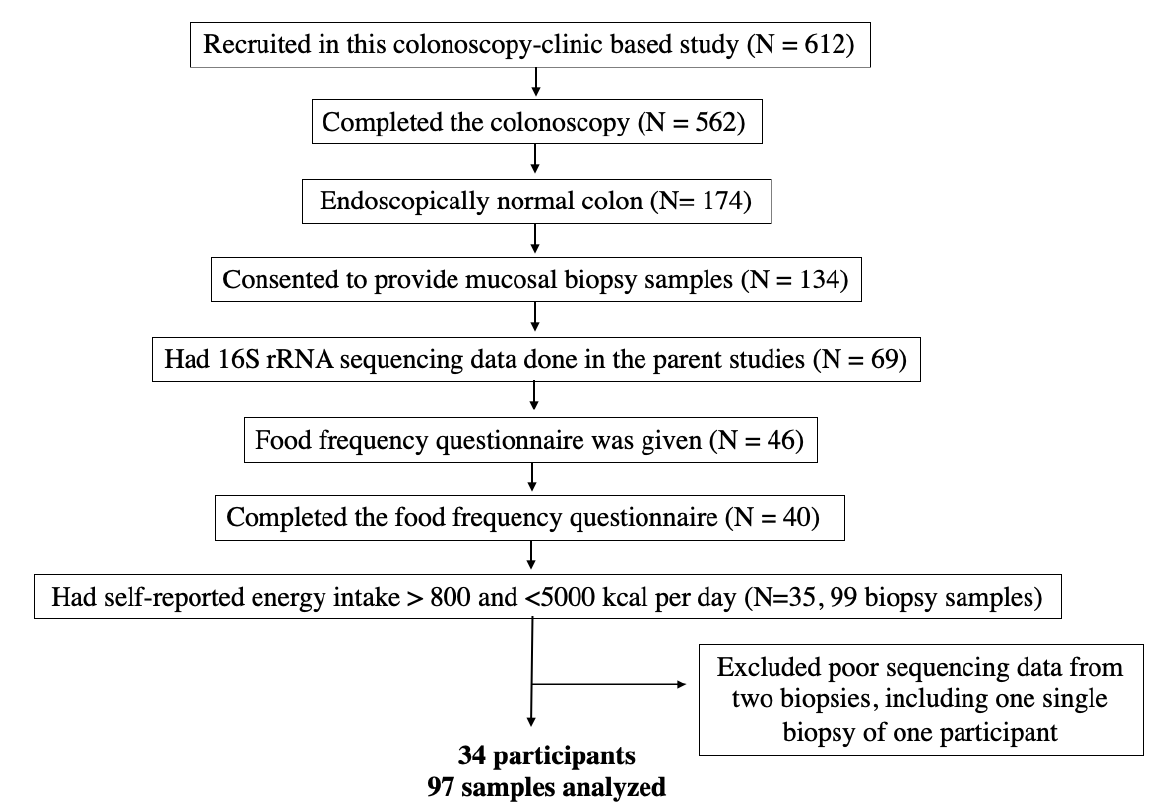
Figure 1. Flow chart of participant eligibility.